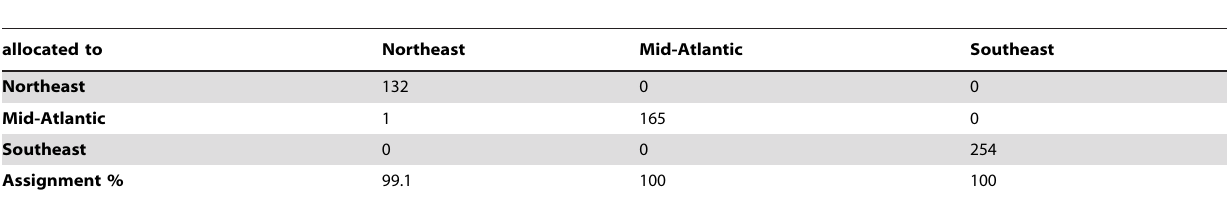
Table 4. Assignment to three groupings of origin model consisting of 17 collections of shortnose sturgeon ( Acipenser brevirostrum ) surveyed at 11 polysomic microsatellite DNA